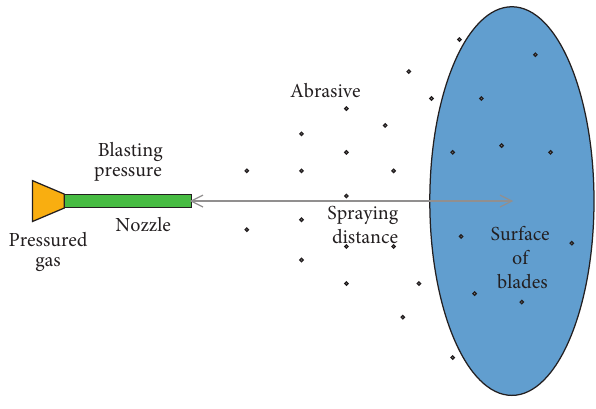
Figure 1: Test setup of sandblasting process. Table 1: Other working parameters of sandblasting process in